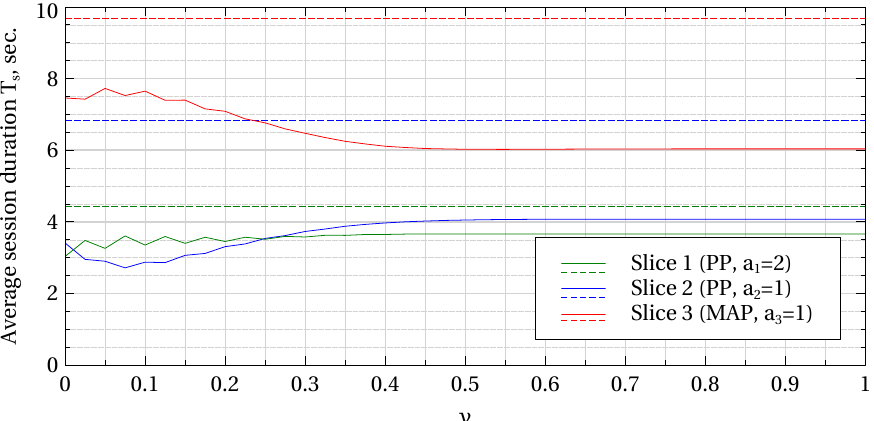
Figure 2. The average user data rates vs. the booked capacity shares γ s = γ , s ∈ S (solid lines—slicing, dashed lines—CP). Note that the CS values coincide with that under slicing for γ = 1 and are not shown explicitly.